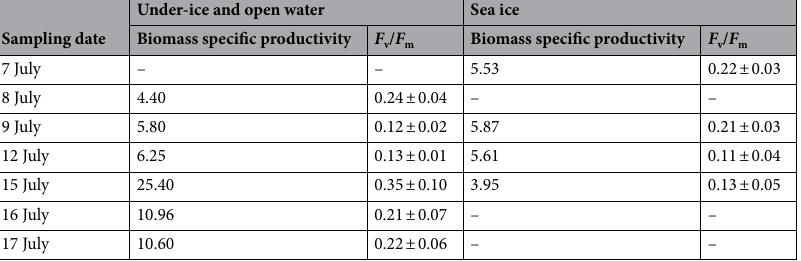
Table 1. Algal productivity and photobiology. Biomass specific productivity (mg C mg Chl a −1 day −1 ) and algal photobiology from 7 to 17 July in under-ice water (1 m), open seawater (1 m) and sea ice. Data points represents treatment mean ± SD (n =